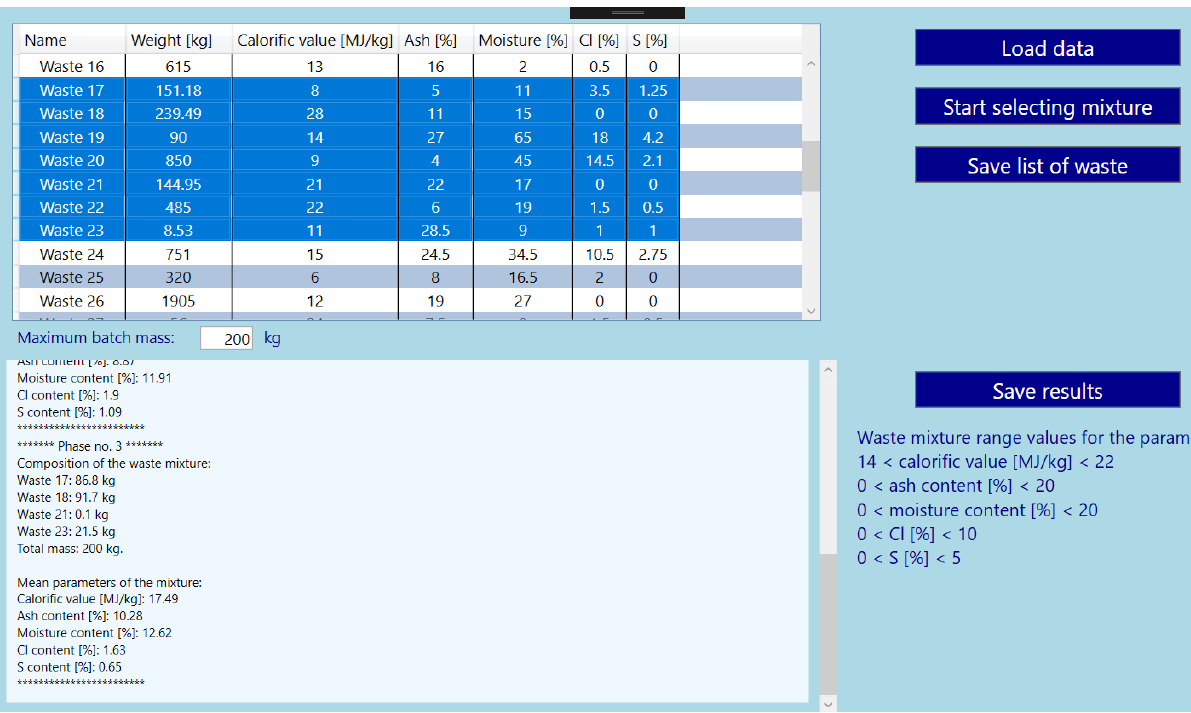
Figure 3. Results of creating batch portion after changing maximum batch mass.